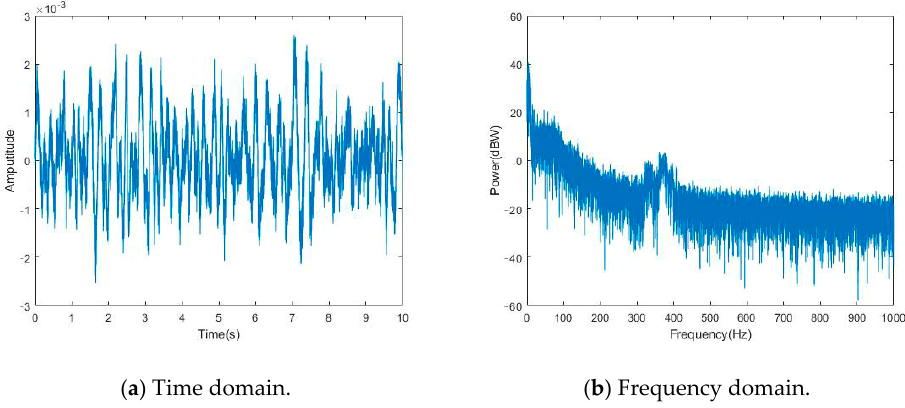
Figure 20. Time domain data and frequency domain data of the target echo signal.